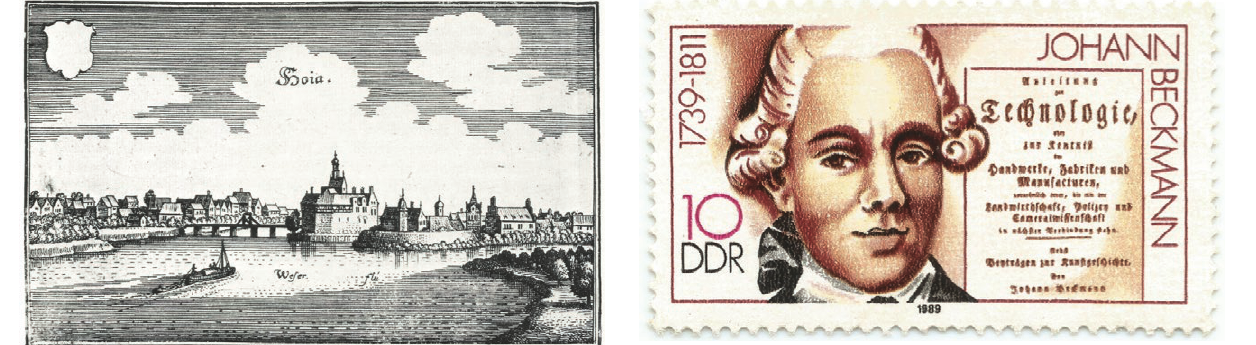
Figure 2. View of the city of Hoya, 17th century. Engraving by Mat- thäus Merian the Older (1593-1650). (Courtesy Johann-Beckmann- Gesellschaft).